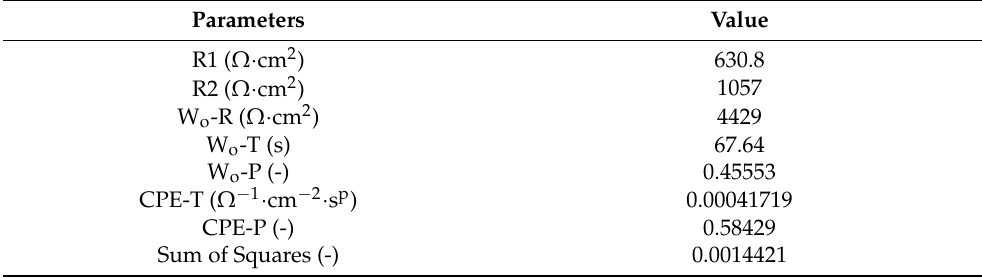
Table A2. Parameters of the fit of the Ultrasonic